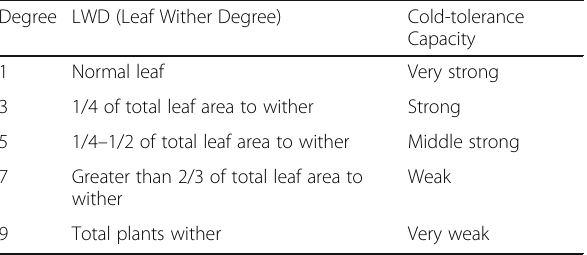
Additional file 2: Table S2. The value of comprehensive index for each variety. Additional file 3: Table S3. The subordinate function value of every variety. Additional file 4: Table S4. the comprehensive evaluation value ( D ) of each variety. Additional file 5: Table S5. The value of the nine physiological index.